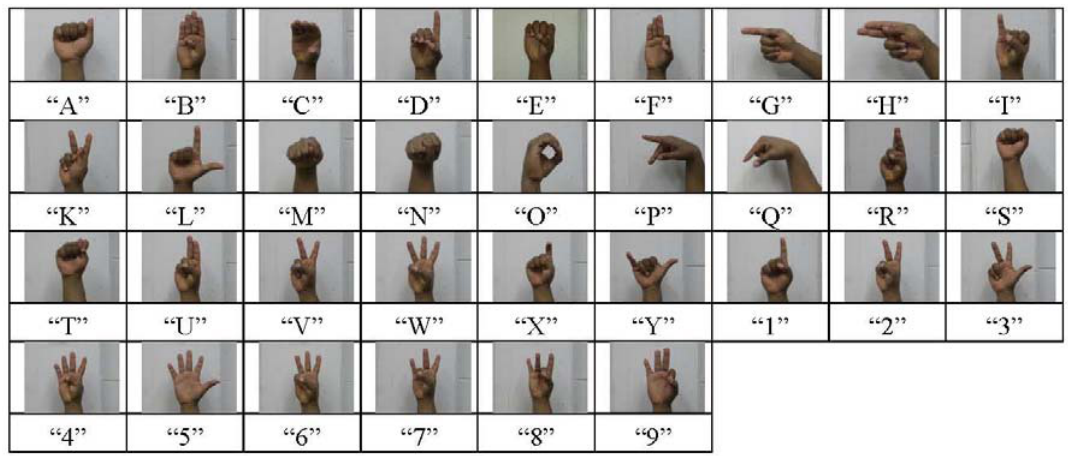
Figure 13. The 33 considered gestures (Dynamic gestures J and Z are out of scope of this study).